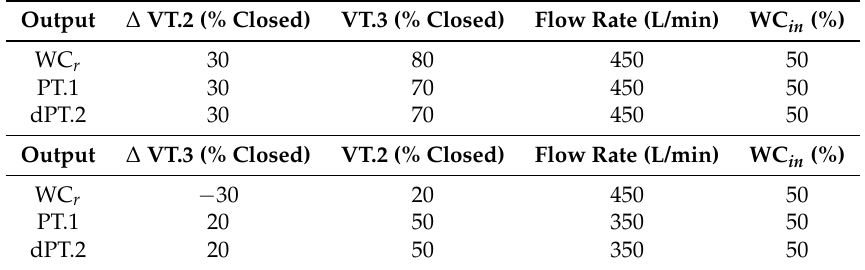
Table 3. Inlet conditions and changes in valve openings used in step response experiments.